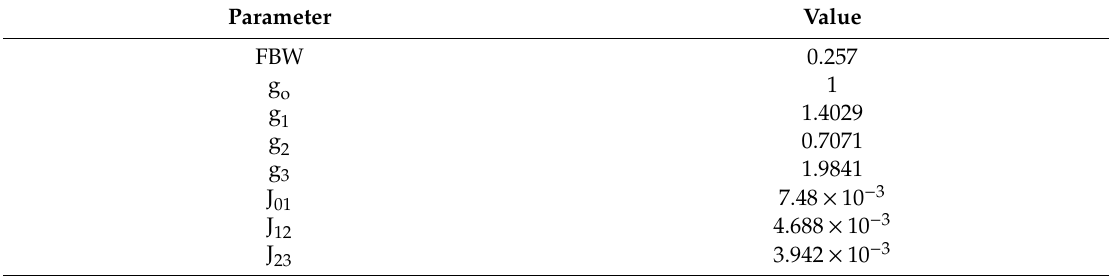
Table 2. Second-order Chebyshev bandpass filter